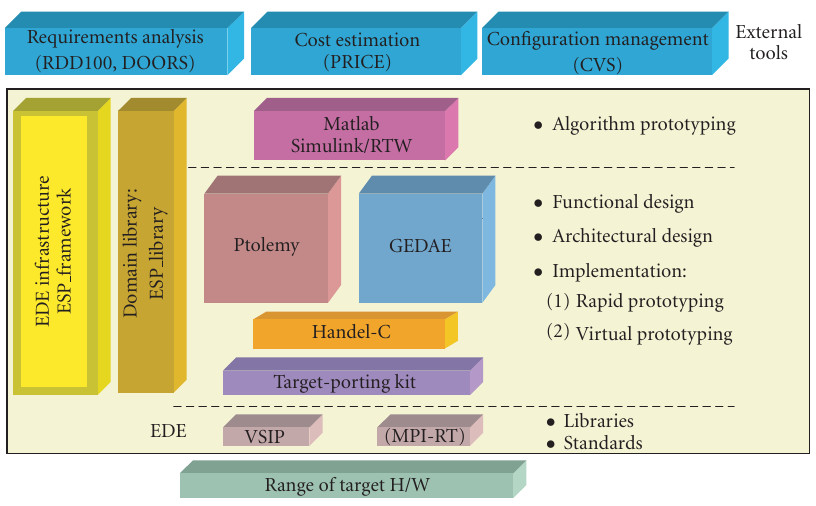
Figure 4: ESPADON design